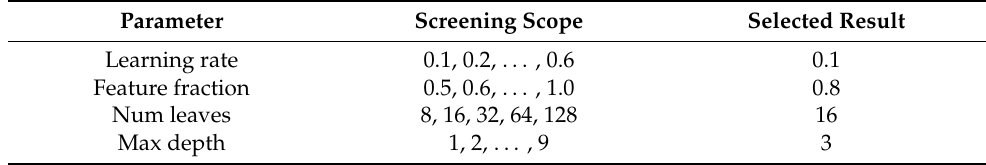
Table 5. Parameter adjustment table of LightGBM-MIC.